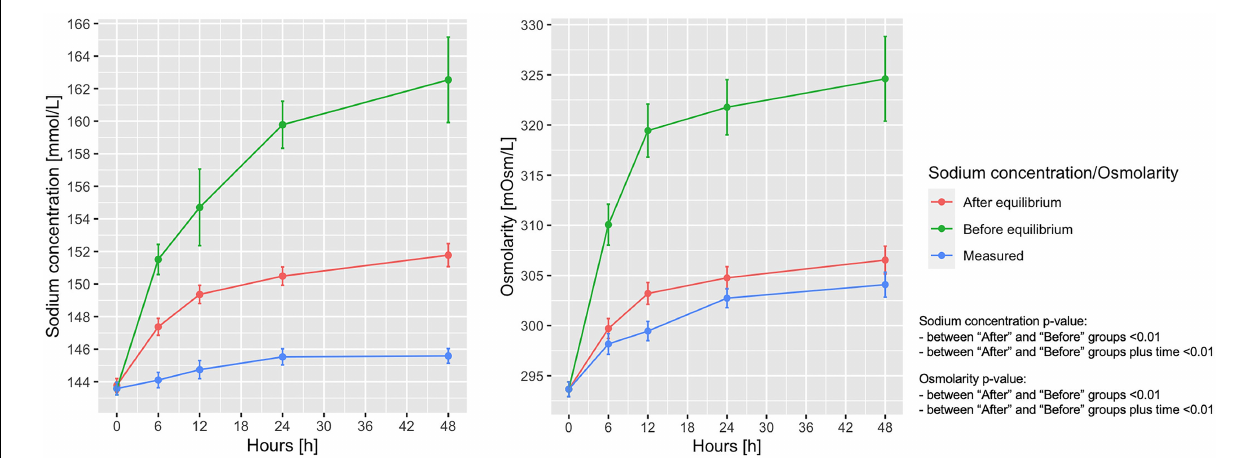
FIGURE 4 | Measured and calculated sodium concentration and osmolarity before and after osmotic equilibrium. Line-plot over the 48 h of the experiment. Statistic: linear mixed effects model comparing the “before” and “after” osmotic equilibrium values. Sodium concentration: data available in 78 animals at 0 h for the three items, and in 65 at 48 h for measured sodium, 65 for expected sodium before equilibrium, and 55 for expected sodium after equilibrium. Osmotic concentration: data available in 78 animals at 0 h in the three items, and in 65 for measured osmotic concentration, 55 for expected osmotic concentration before equilibrium, and 55 for expected osmotic concentration after equilibrium.